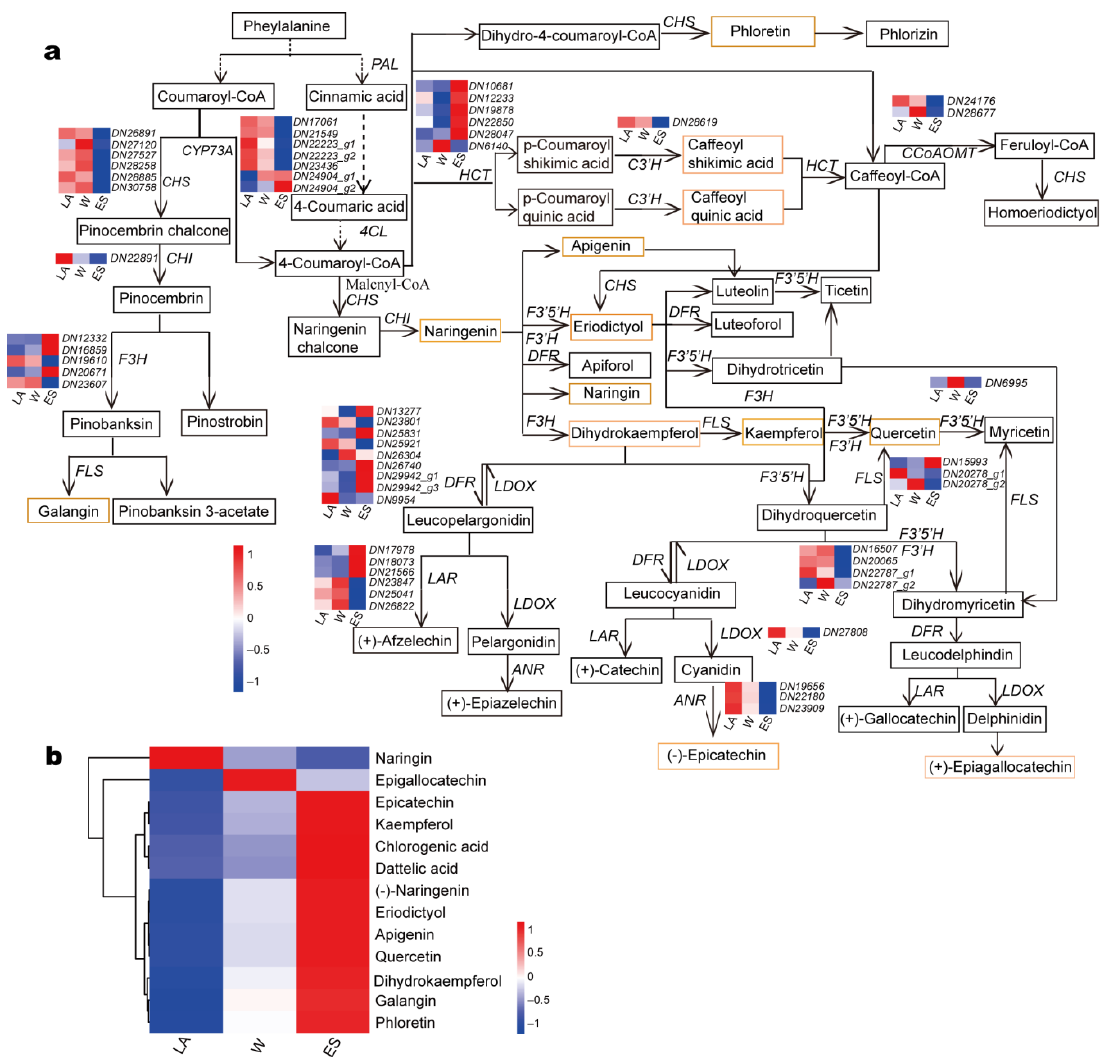
Figure 6. Metabolites and unigenes involved in flavonoid biosynthesis that were differentially expressed in overwintering C. fortunei . ( a ) Unigenes involved in flavonoid biosynthesis pathway. Boxed text indicates the metabolites in the metabolic pathway and text within yellow boxes indicates detected metabolites. The heatmap represents unigene expression levels after normalizing the row data, and red and blue represent high and low expression, respectively. Each column and each row represent a sample and a unigene, respectively. The content in italics indicates genes, and these gene abbreviations are as follows: 4CL , 4-coumarate-CoA ligase ; ANR , anthocyanidin reductase ; C3’H , 5-O-(4-coumaroyl)-D-quinate 3’-monooxygenase ; CHI , chalcone isomerase ; CHS , chalcone synthase ; CCoAOMT , caffeoyl-CoA O-methyltransferase ; CYP73A , trans-cinnamate 4-monooxygenase ; DFR , bifunctional dihydroflavonol 4-reductase/flavanone 4-reductase ; FLS , flavonol synthase ; F3H , naringenin 3-dioxygenase ; F3’H , flavonoid 3’-monooxygenase ; F3’5’H , flavonoid 3’,5’-hydroxylase ; HCT , shikimate O-hydroxycinnamoyltransferase ; LAR , leucoanthocyanidin reductase ; LDOX , leucoanthocyanidin dioxygenase ; PAL , phenylalanine ammonia-lyase. ( b ) Hierarchical clustering heatmap of DSMs involved in flavonoid biosynthesis. Heatmap represents metabolite content after normalizing the row data. The text below the heatmap indicates the sampling time, and the text to the right of the heatmap indicates the metabolite. Red represents high metabolite contents, and blue represents low metabolite contents. Sample abbreviations are as follows: ES, early spring; LA, late autumn; and W, winter.